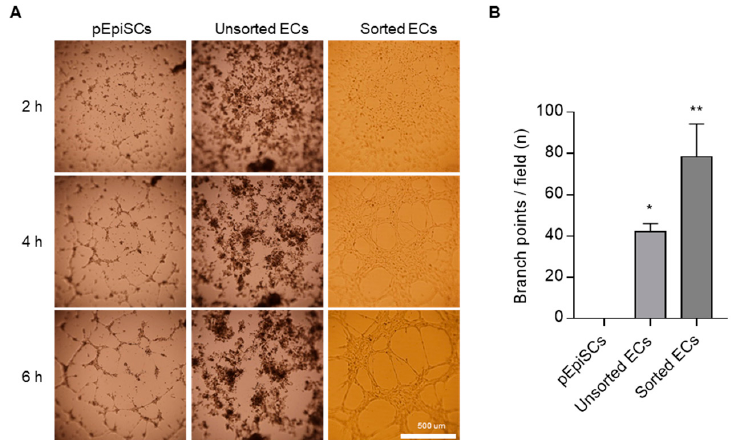
Figure 4. Formation of capillary-like structure of sorted ECs. ( A ) 2.0 × 10 4 of cells were cultured in 96-well cell culture plates on matrigel. Formation of capillary-like structures of sorted ECs was observed on matrigel for 6 h. Scale bar = 500 µ m. ( B ) Branch points of pEpiSCs, unsorted ECs and sorted EC was counted. Values presented as mean SEM. * p < 0.05, ** p < 0.01 vs. pEpiSCs, n.s.: not significant.